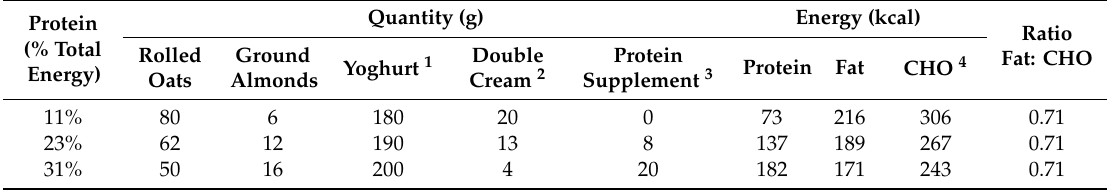
Table 1. Test meal composition (calculated) as a load for assessing postprandial